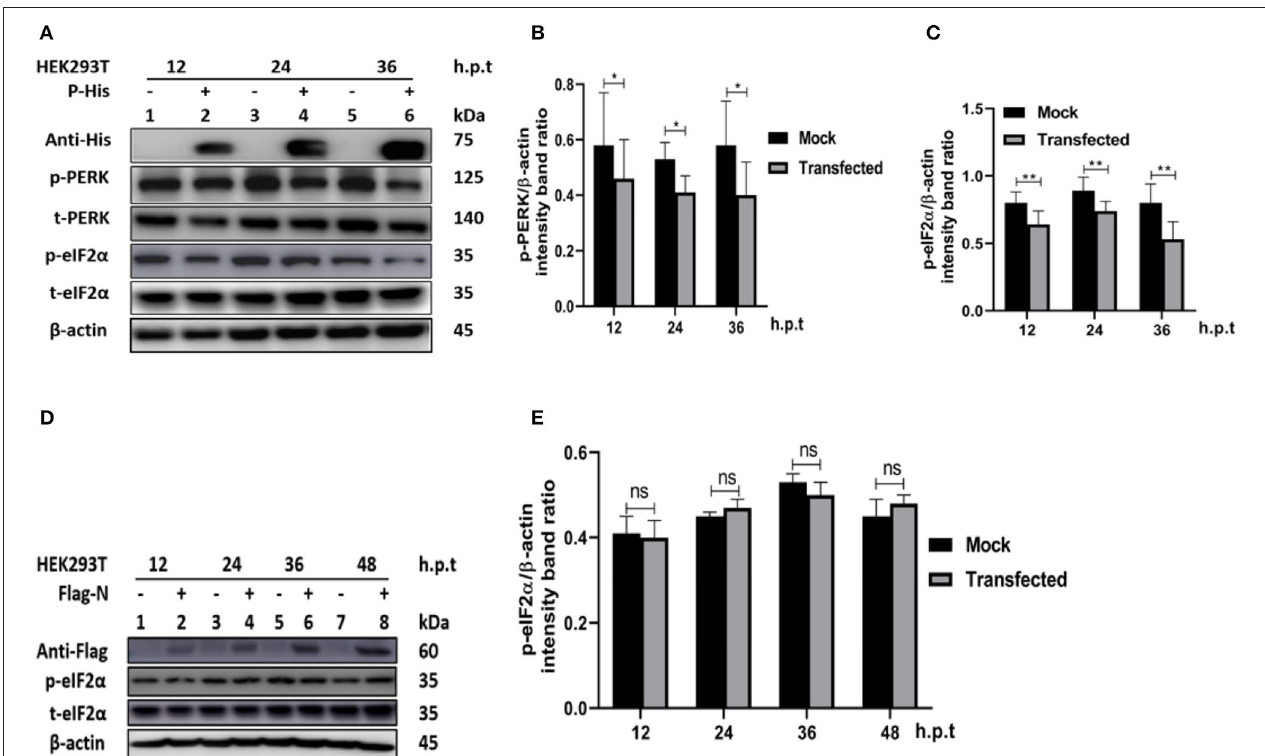
FIGURE 5 | PPRV P protein but not PPRV N protein blocks PERK/eIF2 α phosphorylation. (A–C) PPRV P protein blocks eIF2 α phosphorylation. HEK293T cells were transfected with His-tagged P protein expressing plasmid or mock-transfected with an empty vector at indicated times. The effect of PPRV P protein on p-PERK and p-eIF2 α expression was analyzed by Western blot. (D,E) PPRV N does not block eIF2 α phosphorylation. HEK 293T cells were transfected with Flag-tagged N protein expressing plasmid or mock-transfected with an empty vector at indicated times. The effect of PPRV N on p-eIF2 α expression was analyzed by Western blot. In all sets, the expression of PPRV P and PPRV N proteins was confirmed by Western blotting probed with anti-His (A) and anti-Flag (D) antibodies, respectively. Densitometry quantification of p-PERK (B) or p-eIF2 α (C,E) was normalized to β -actin and fold change was measured and compared with mock-transfected cells within each time point by ImageJ. Statistical analysis was performed using GraphPad Prism 8.0 software. On the graphs, shown are representative immunoblots with the error bars representing the mean ± SD from three independent experiments. Asterisks represent statistically significant differences between mock and transfected cells (* P < 0.5; ** P < 0.01; ns, not